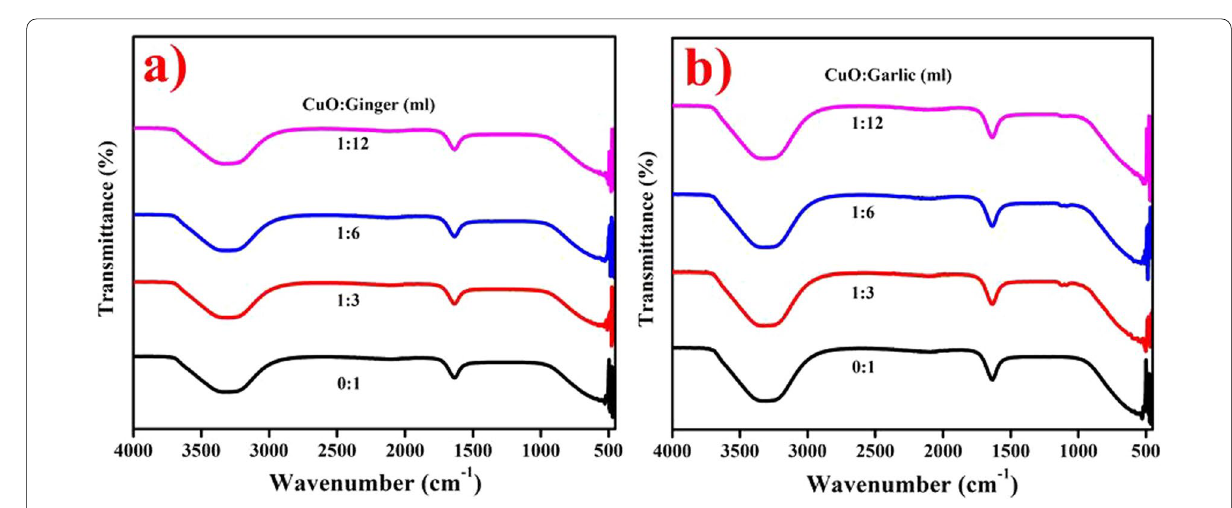
Fig. 4 FTIR spectra of a AS b ZO‑doped CuO